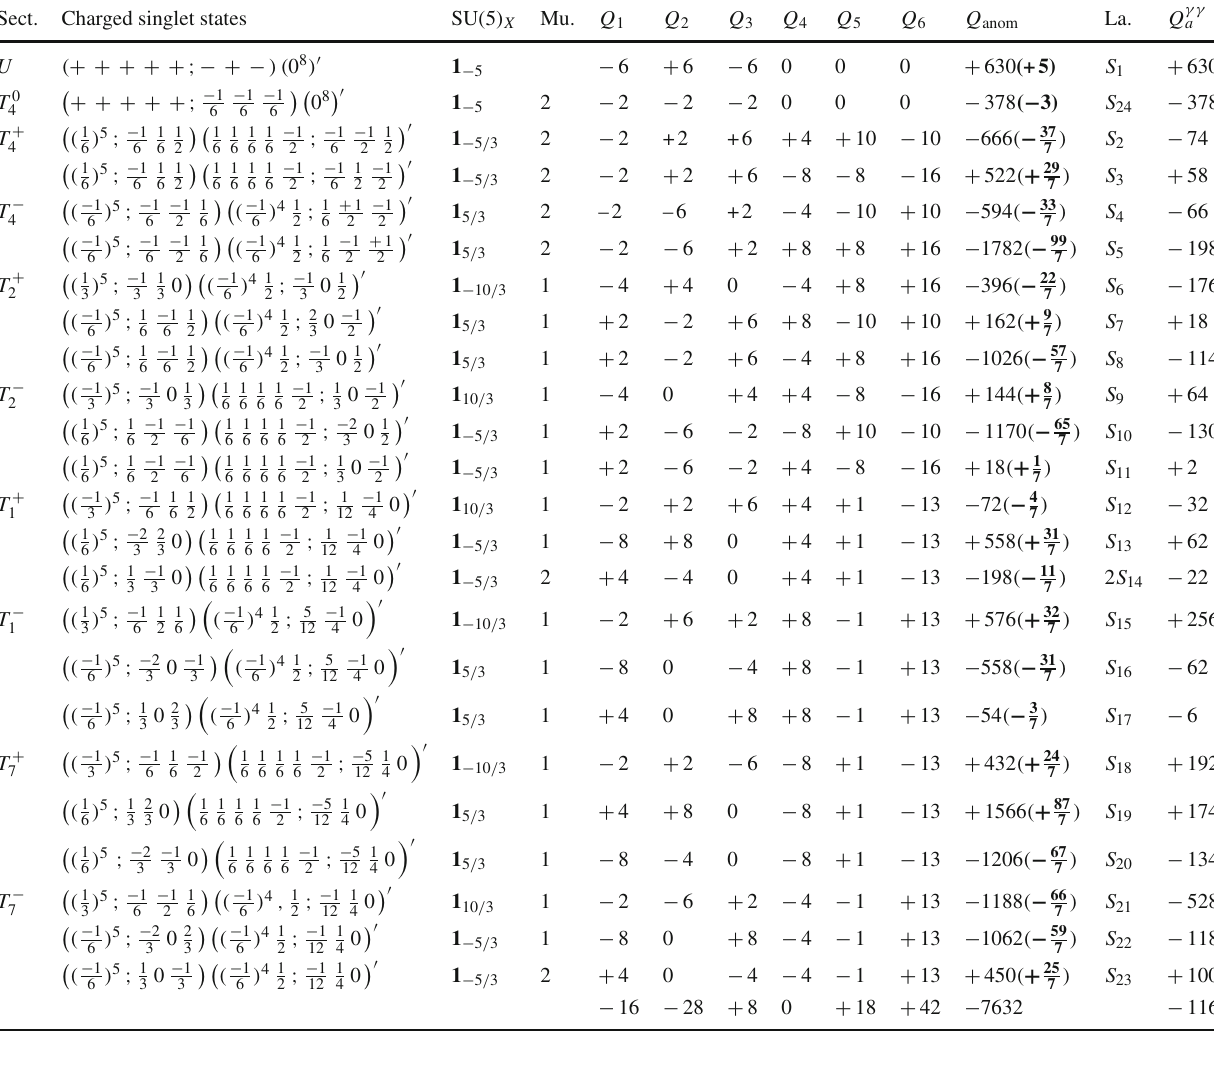
Table 3 Electromagnetically charged singlets Sect. Charged singlet states SU(5)